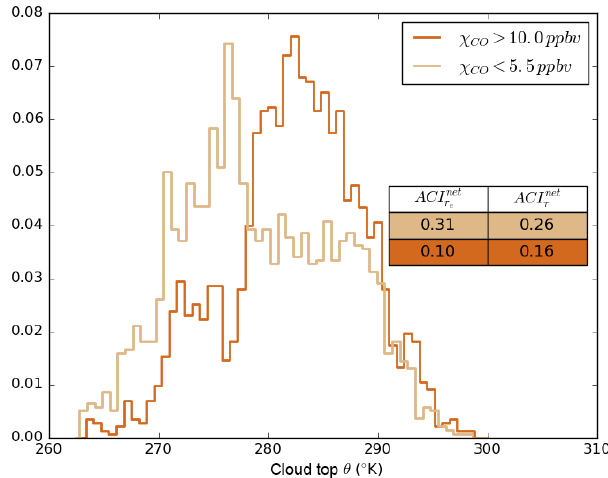
Figure 8. Normalized distribution of the cloud top potential tem- perature when clouds are associated with CO tracer concentrations ( χ CO ) greater than 10ppbv and less than 5ppbv. The values of ACI net r and ACI net τ associated with each histogram are presented e also in Table